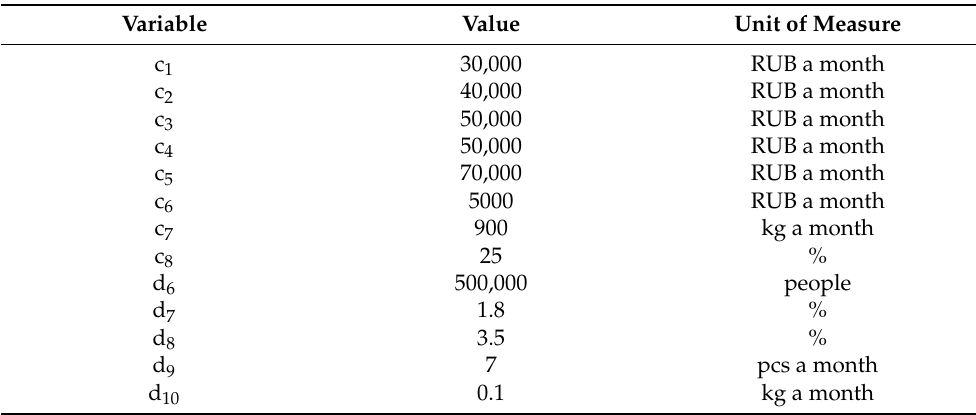
Table 13. Values of the statistical variables of the model.